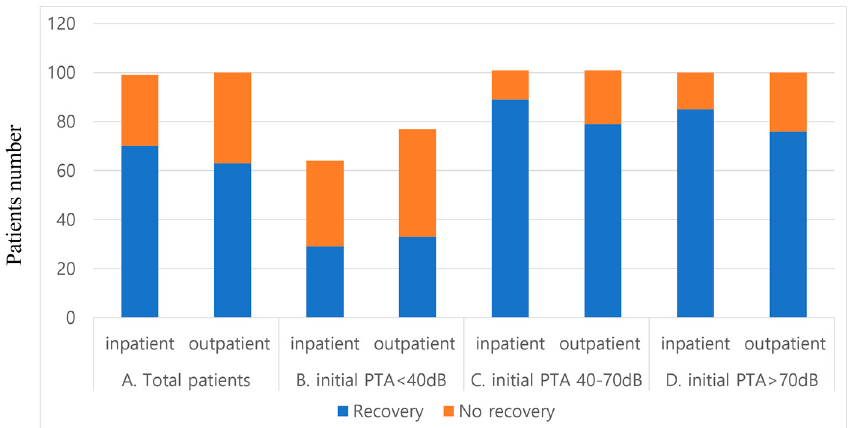
Figure 1. The functional recovery rate based on modified Siegel’s criteria. ( A ) Comparison of the functional recovery rate of all patients ( p < 0.05). ( B ) Comparison of the functional recovery rate of patients with a hearing level under 40 dB ( p > 0.05). ( C ) Comparison of the functional recovery rate of patients with a hearing level ranging from 40–70 dB ( p > 0.05). ( D ). Comparison of the functional